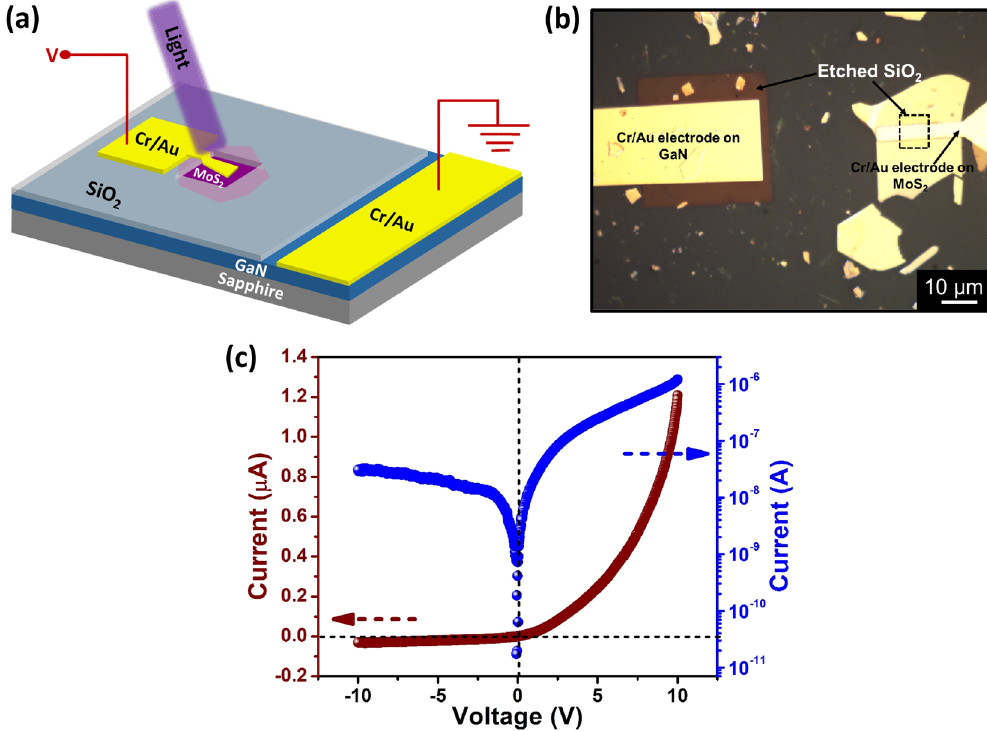
Figure 1. ( a ) 3D Schematic illustration of MoS 2 /GaN heterojunction device. ( b ) Optical microscope image of the fabricated heterojunction with Cr/Au (5 nm/50 nm) contacts. ( c ) Two terminal electrical measurements of the MoS 2 /GaN heterojunction diode under dark conditions showing clear current